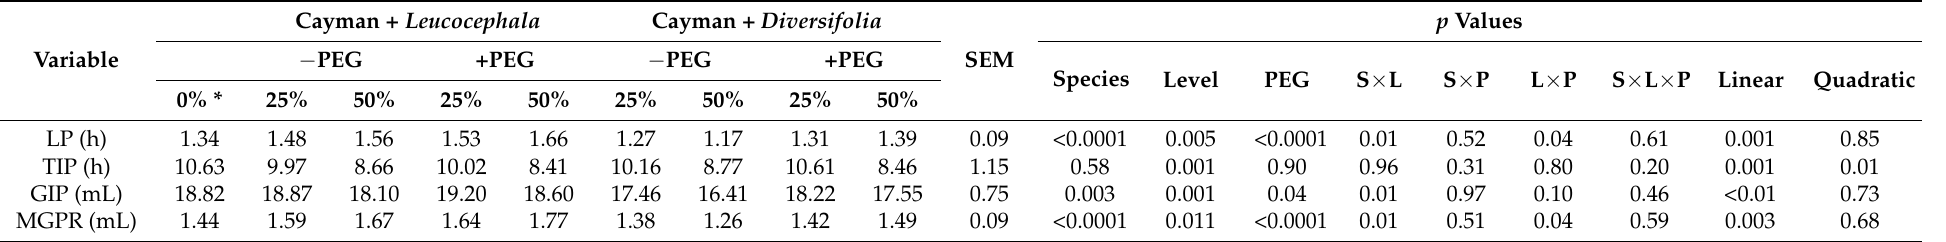
Table 2. Effect of Leucaena inclusion on the degradation kinetics of Urochloa hybrid cv Cayman grass-based treatments. Cayman: Urochloa hybrid cv. Cayman (CIAT